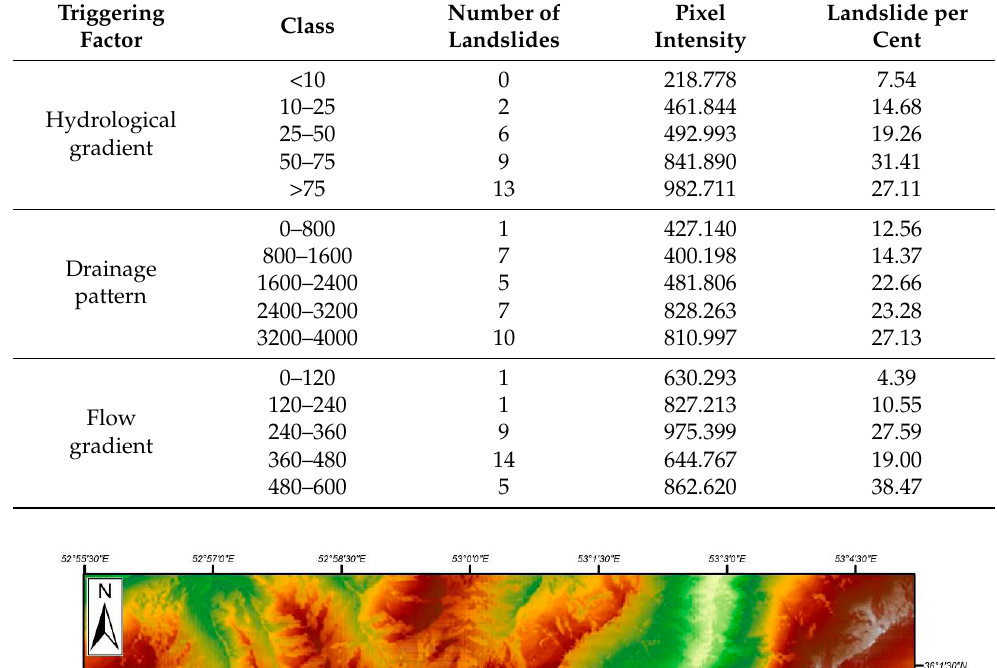
Figure 7. Flowchart of the CNN-based methodology.